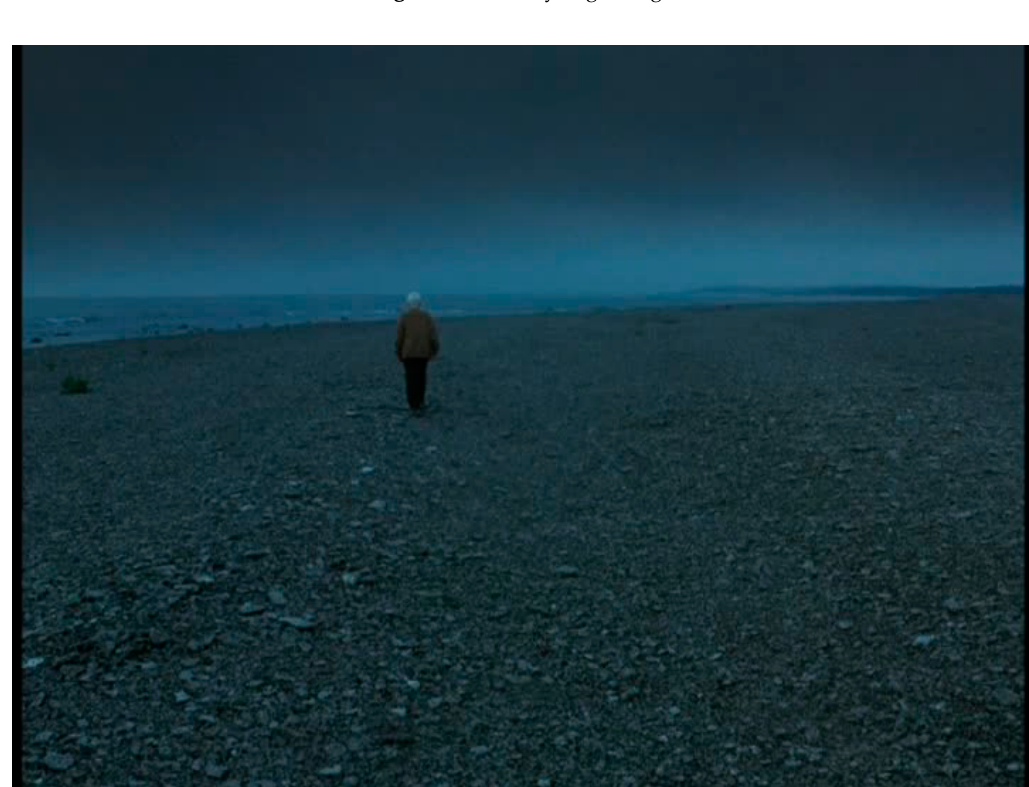
Figure 11. Solitary ending.